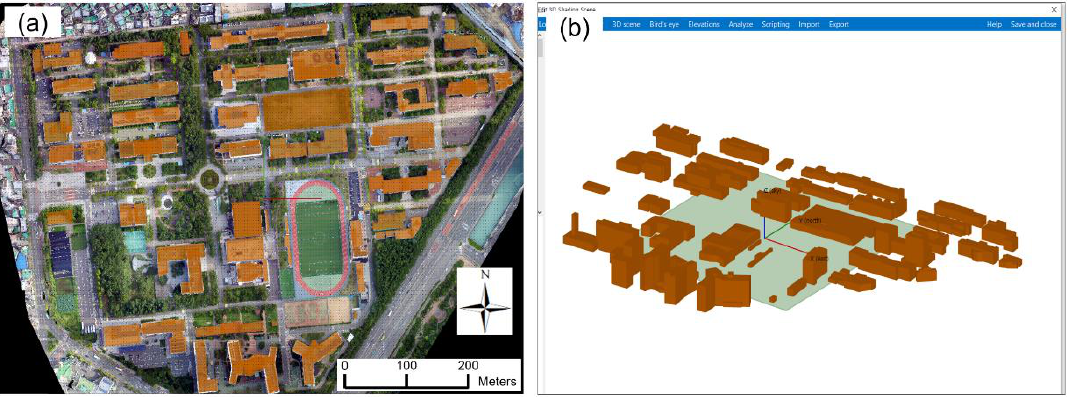
Figure 8. ( a ) Aerial view and ( b ) perspective view of 3D building models of the study area.